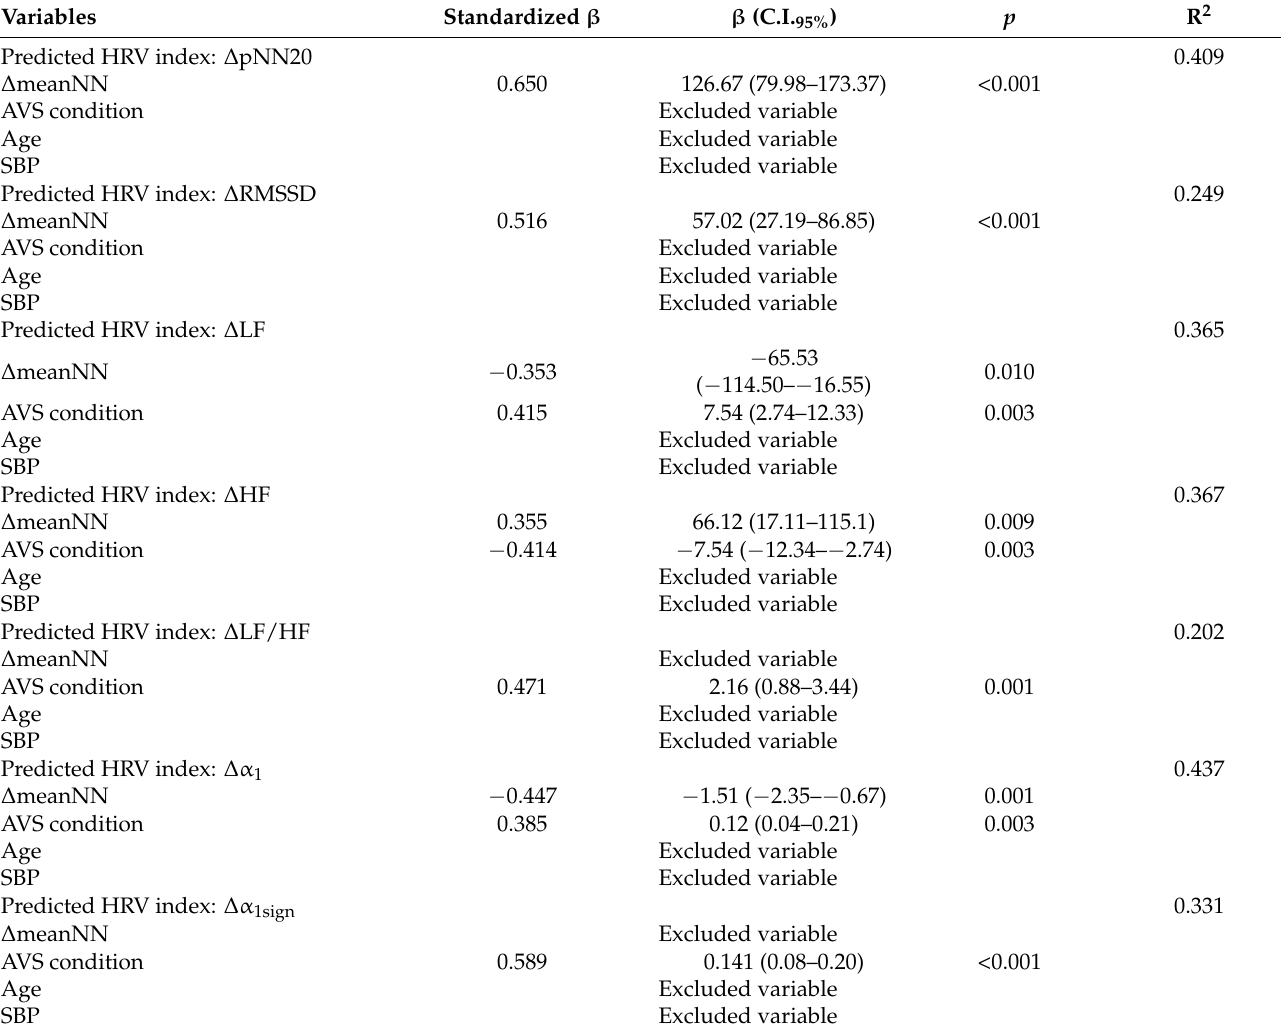
Table 6. Linear stepwise multiple regression analysis with predicted heart rate variability (HRV) indices, and independent variables: ∆ meanNN (s), the aortic valve stenosis (AVS) condition (dichotomized), systolic blood pressure (SBP, mmHg) and age